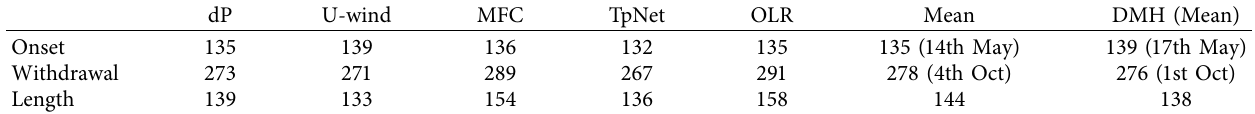
Table 3: Comparison of monsoon onset and withdrawal dates (by day of the year) by CPI index of each parameter. dP